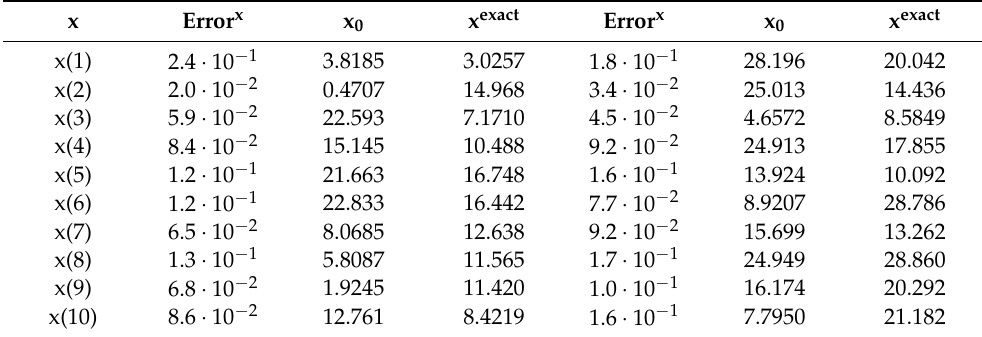
Table 11. Counterpart of Table 10 when adding random noise to the sensors’ data. The temperature T 4 t is computed with an error ∼ 0.2